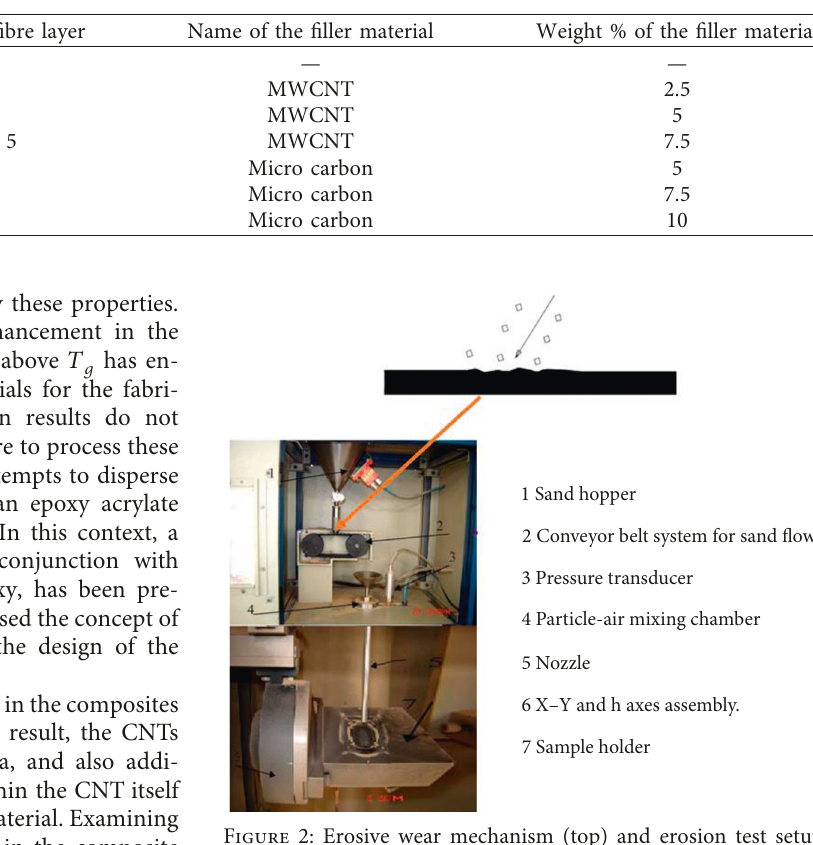
Figure 1: SEM images of materials incorporated (a) CNTs and (b) carbon particles. Table 1: Carbon particle wt. % distributed in prepared materials.